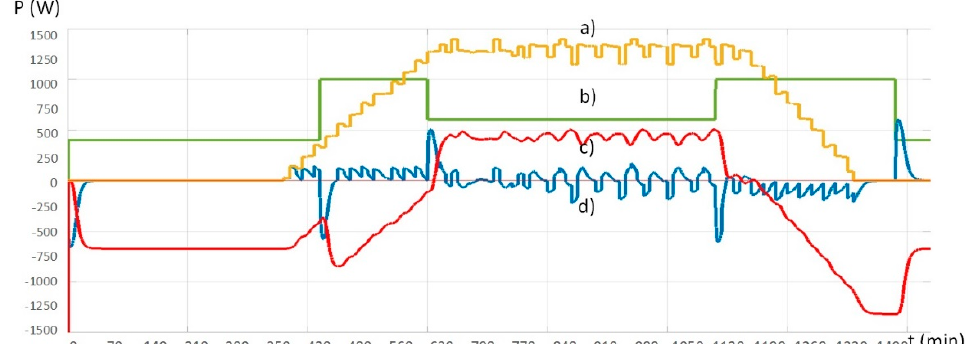
Figure 12. Simulation process for sunny day conditions. Storage system filter with damping ratio ζ = 0.1: ( a ) the PV plant production, ( b ) the power required by the consumer, ( c ) the battery storage power and ( d ) the supercapacitor power.